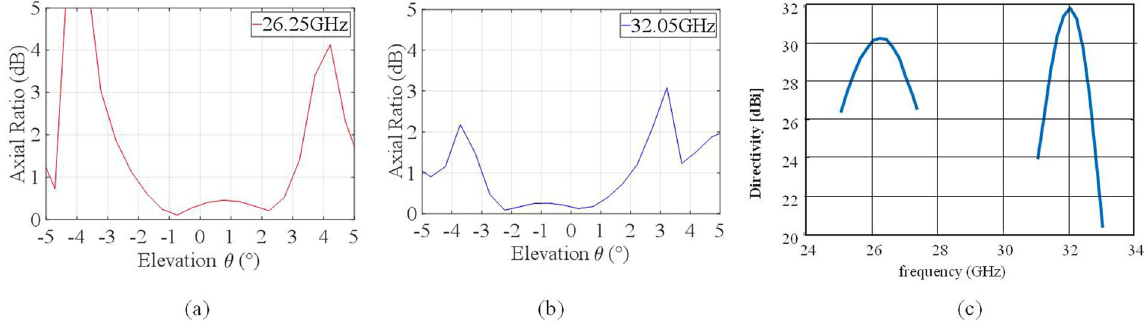
Figure 12. Polarization purity and frequency response of the dual band antenna. Polarization axial ratios near boresight respectively at 26.25 GHz ( a ) and 32.05 GHz ( b ); ( c ) Directivity versus frequency around the two frequencies evaluated by